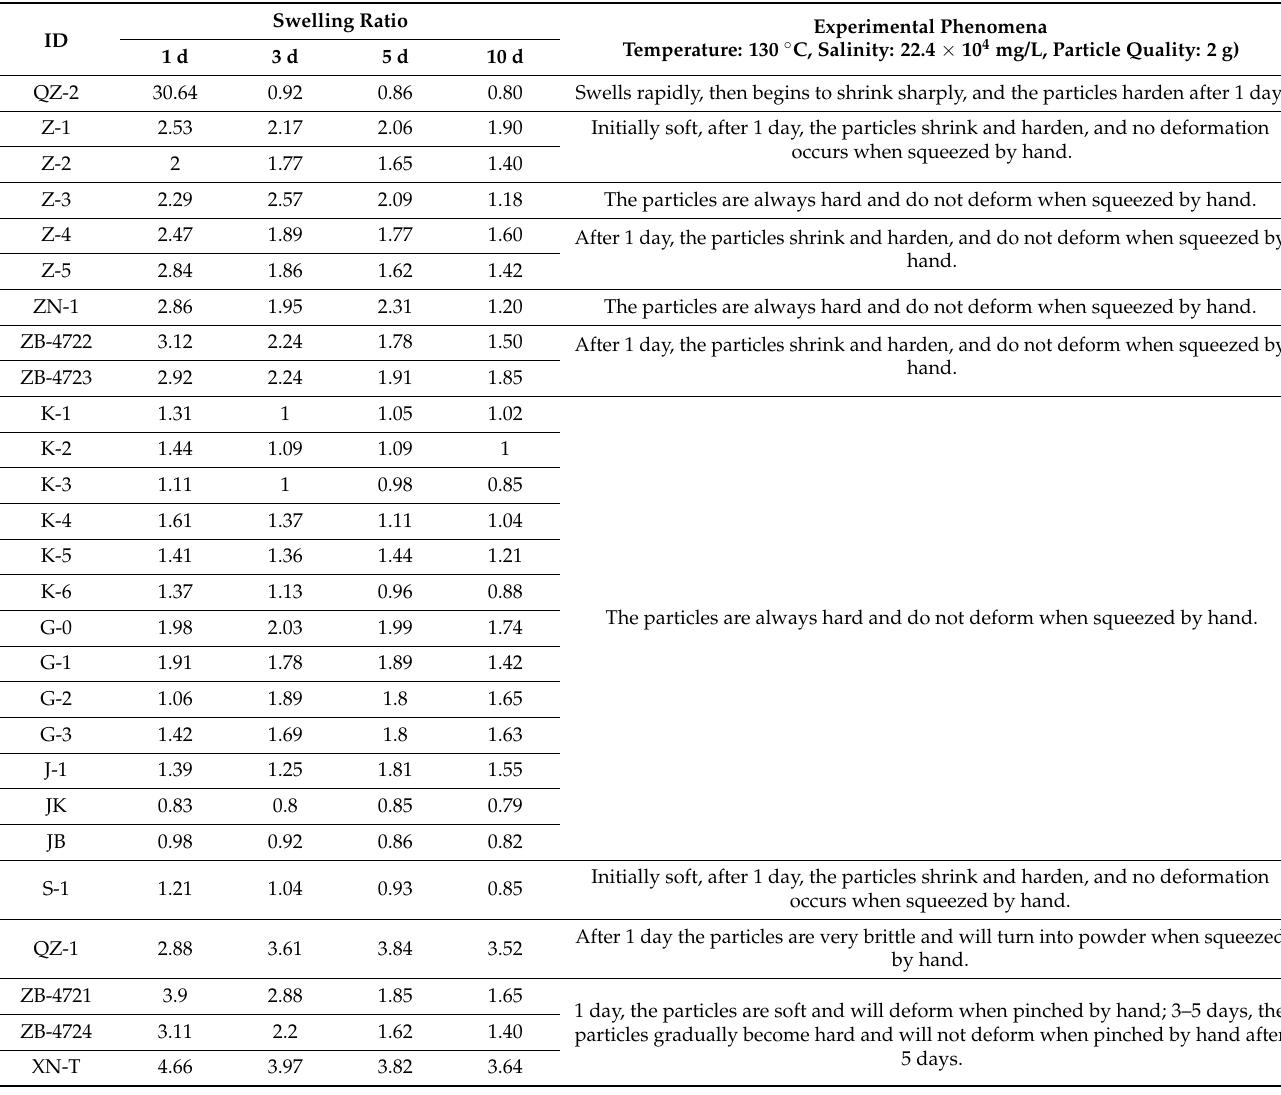
Table A2. Aging tests of 27 kinds of swelling retarding